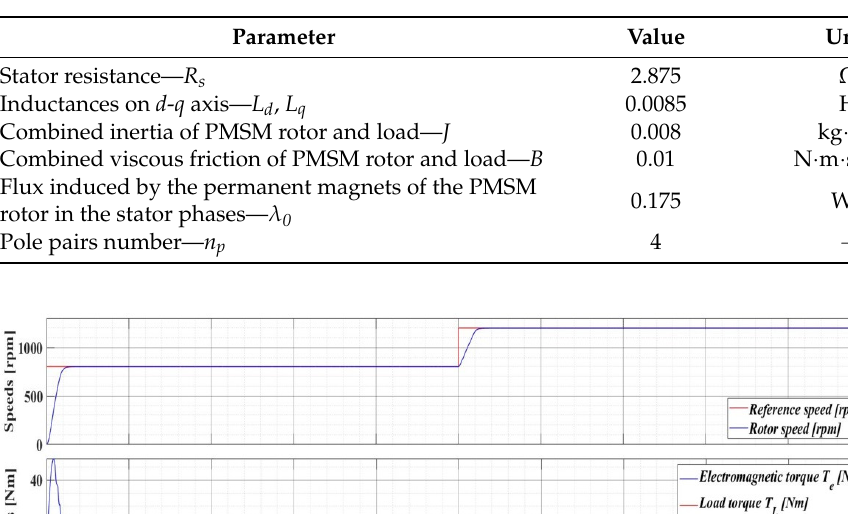
Table 1. PMSM nominal parameters.